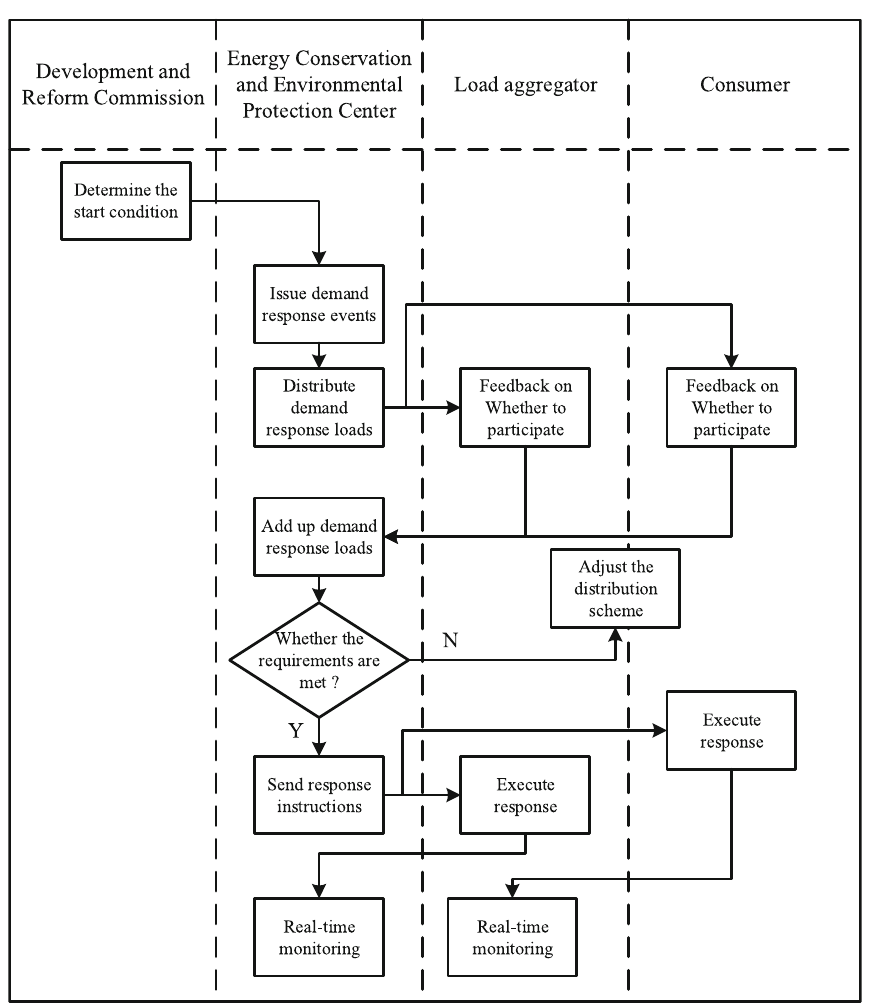
Fig. 2 Execution process of the demand response program in